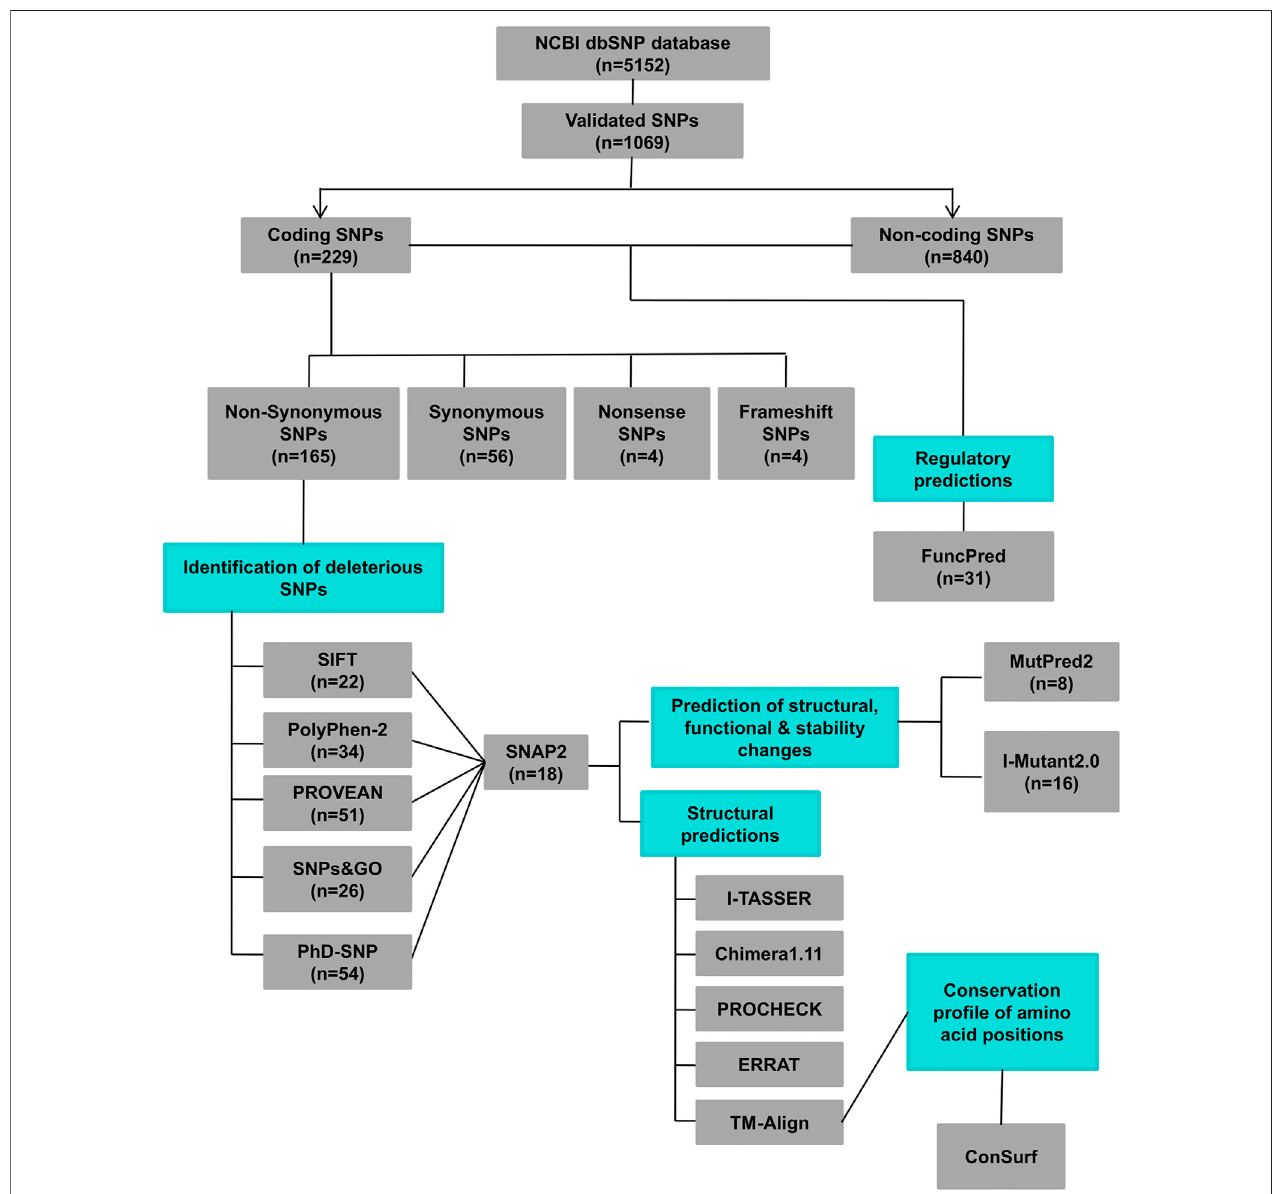
FIGURE 1 | A schematic representation of different in silico tools used at different steps of this study ( n (cid:1) number of SNPs).